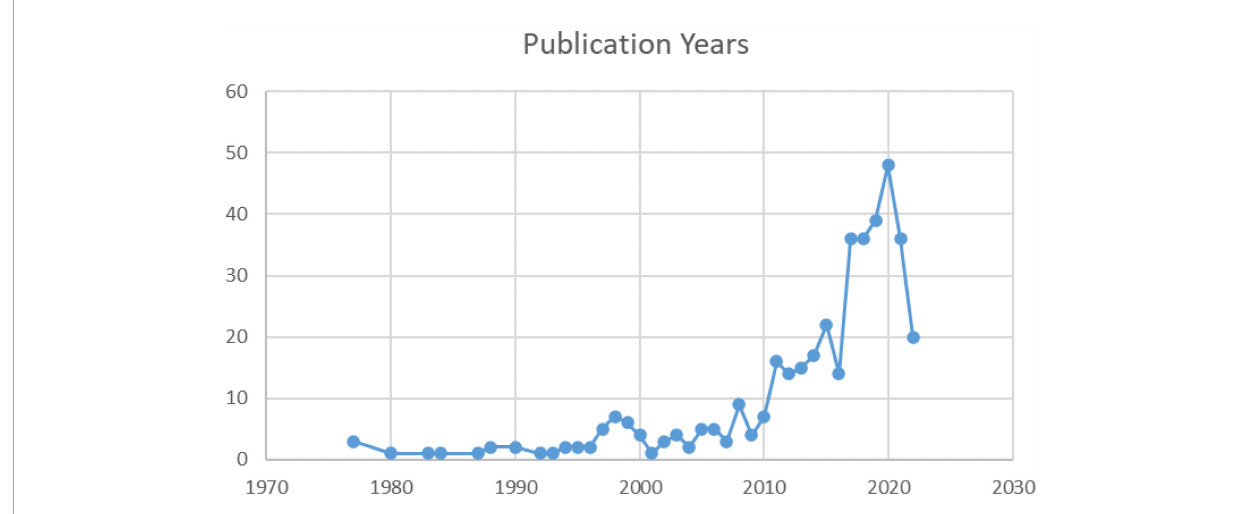
FIGURE1 Trends of annual publication of research in multimodal metaphor.